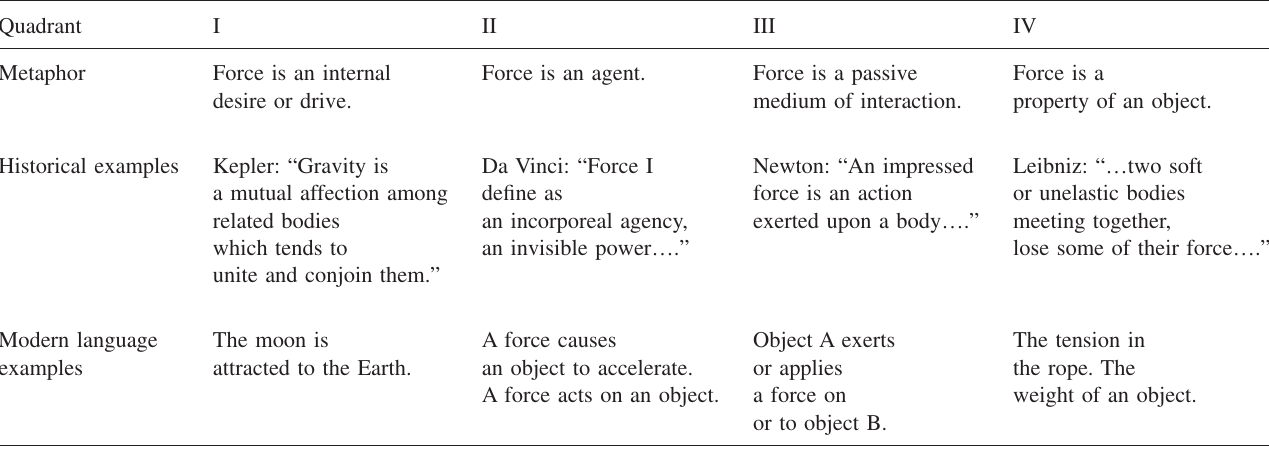
TABLE I. Summary of the four metaphors and examples of historical and modern usage in